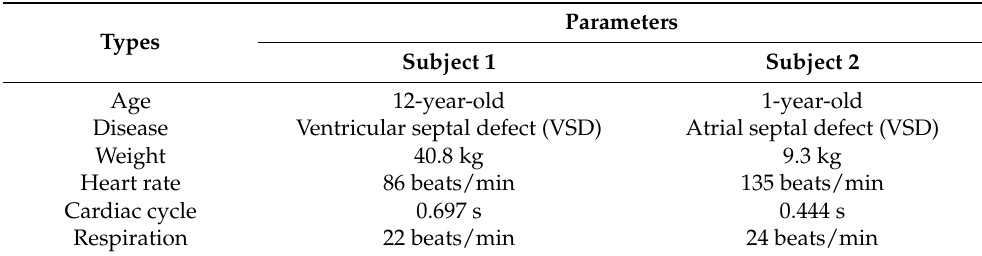
Table 1. Physiological parameters of two research